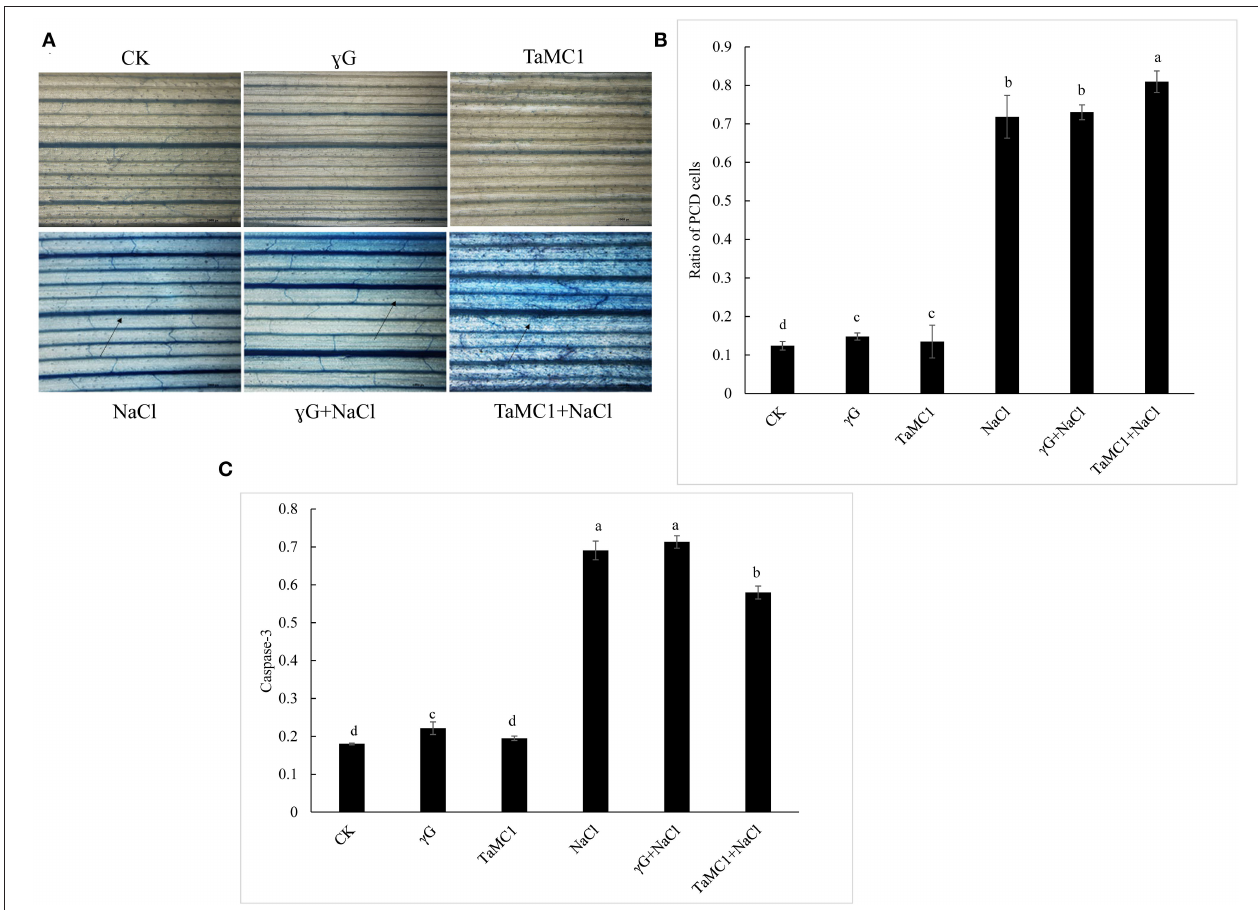
FIGURE 5 | The effect of silencing of TaMCA-Id on cell death in leaves of wheat seedlings under NaCl stress. CK was the wild-type wheat seedlings. γ G was the BSMV-VIGS-GFP - inoculated wheat seedlings. TaMC1 was the BSMV-VIGS-TaMCA-Id - inoculated wheat seedlings. (A) Evans blue staining results. (B) The ratio of PCD cells in wheat leaves determined with Tunel assays. Standard deviations are shown ( n > 3, ± SD, P < 0.05). The different letters in each treatment show the significant difference ( P < 0.05). (C) The effect of silencing of TaMCA-Id on the caspase-3-like activity in leaves of wheat seedlings under NaCl stress. Standard deviations are shown ( n > 3, ± SD, P < 0.05). The different letters in each treatment show the significant difference ( P <